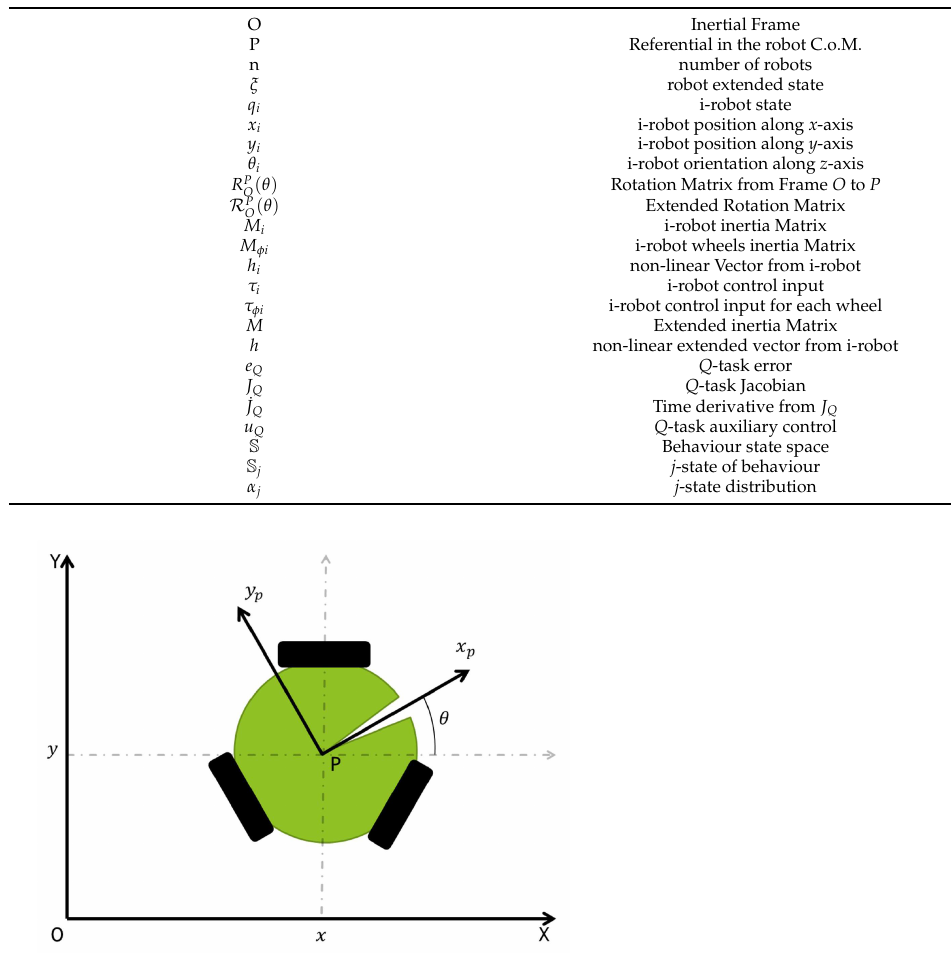
Figure 2. Omni-wheeled robot